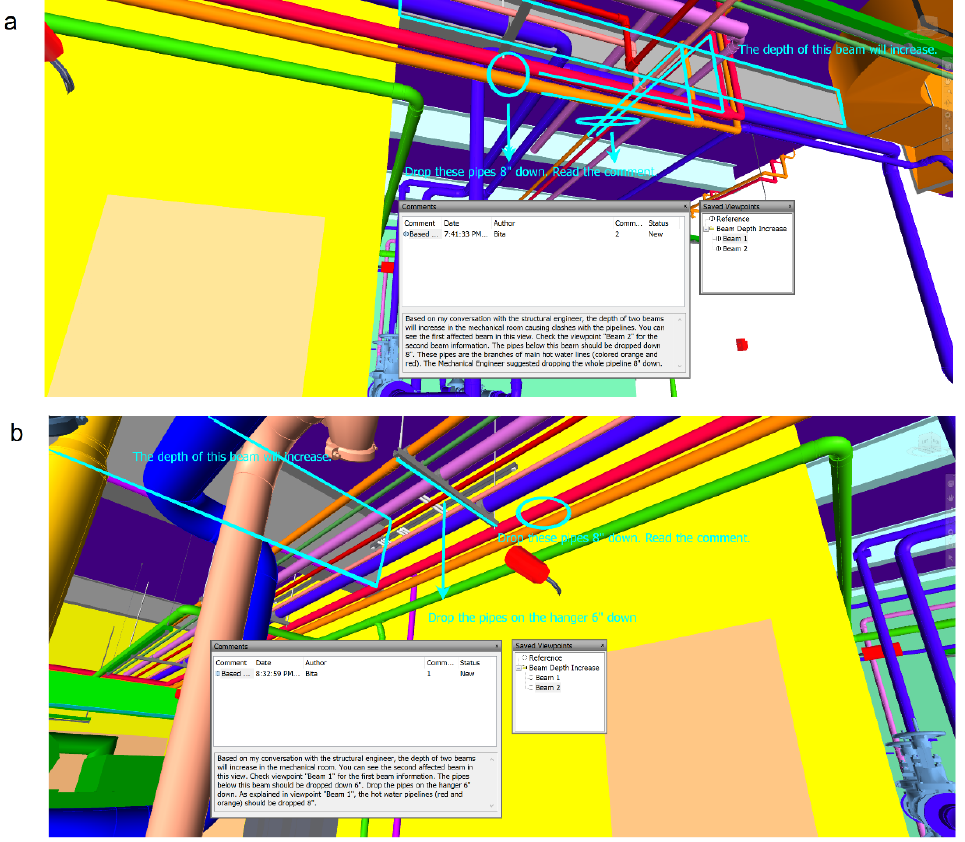
Figure 2. Annotations in the BIM platform for: ( a ) Clash 1; ( b ) Clash 2.